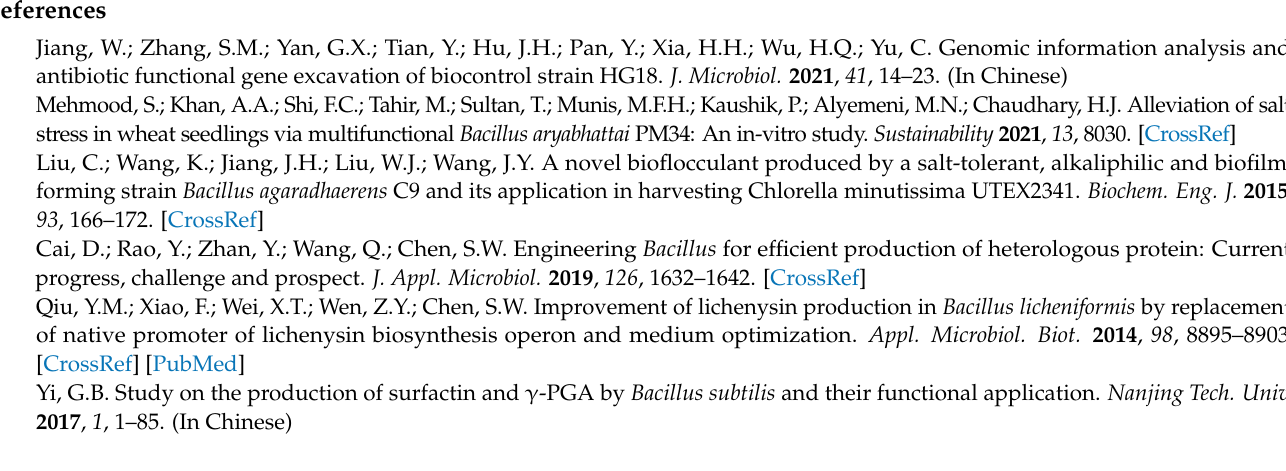
Figure S2: Phylogenetic tree of 30 house-keeping genes using the neighbor-joining